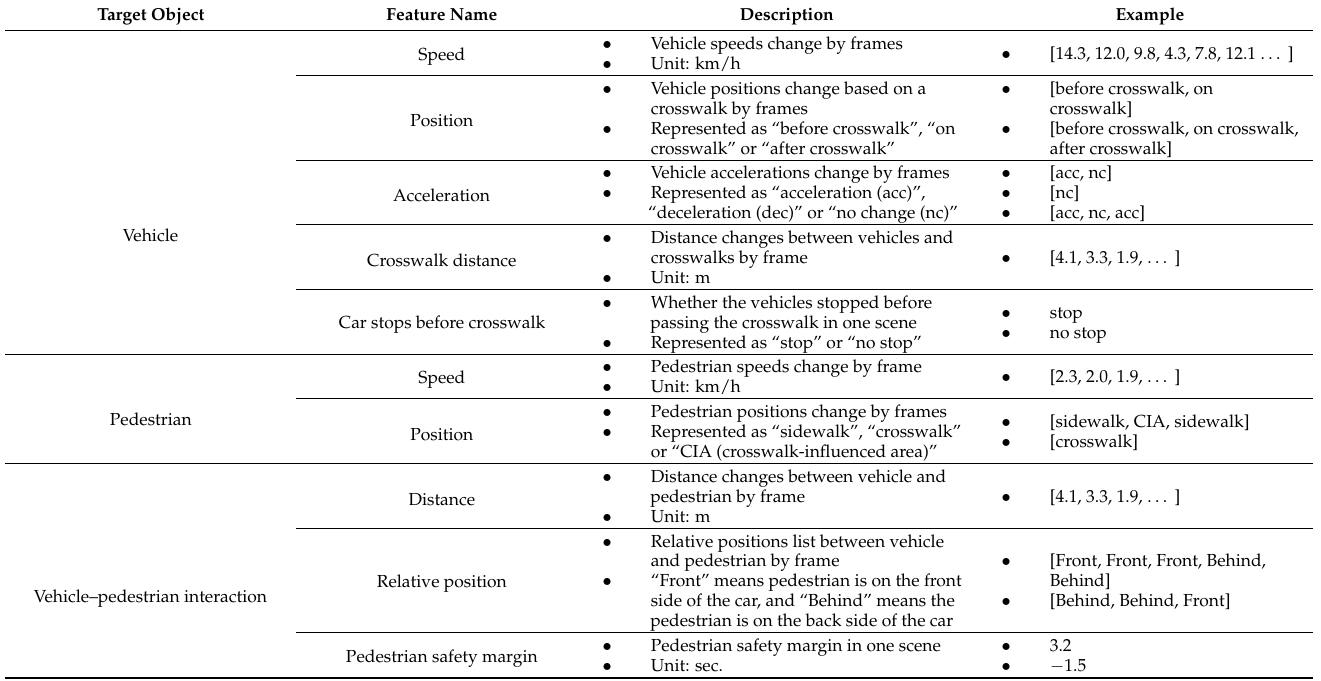
Table 3. The extracted features in our